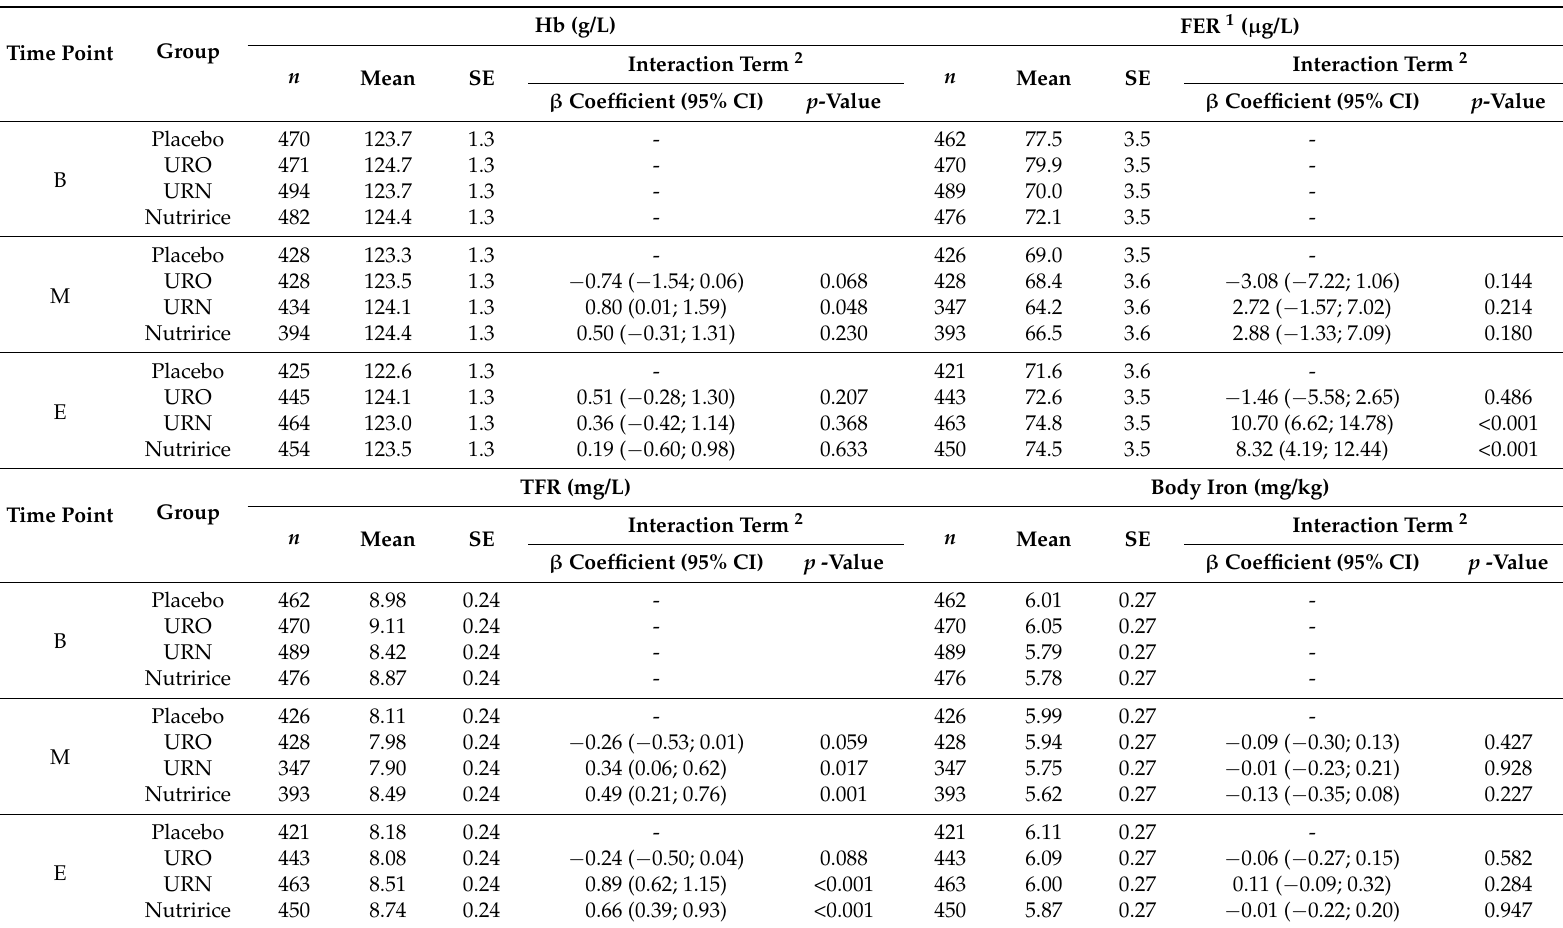
Table 4. Biochemical outcomes and effect sizes after three and six months of intervention for all participating